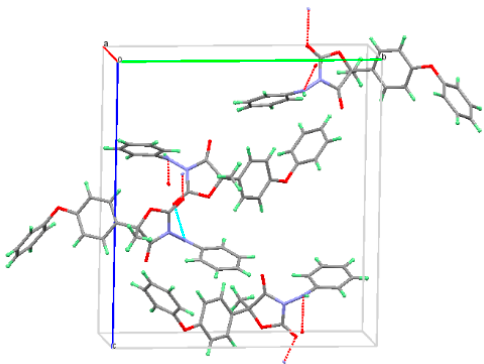
Figure 4. Famoxadone racemic Form I crystal packing projection graphs.